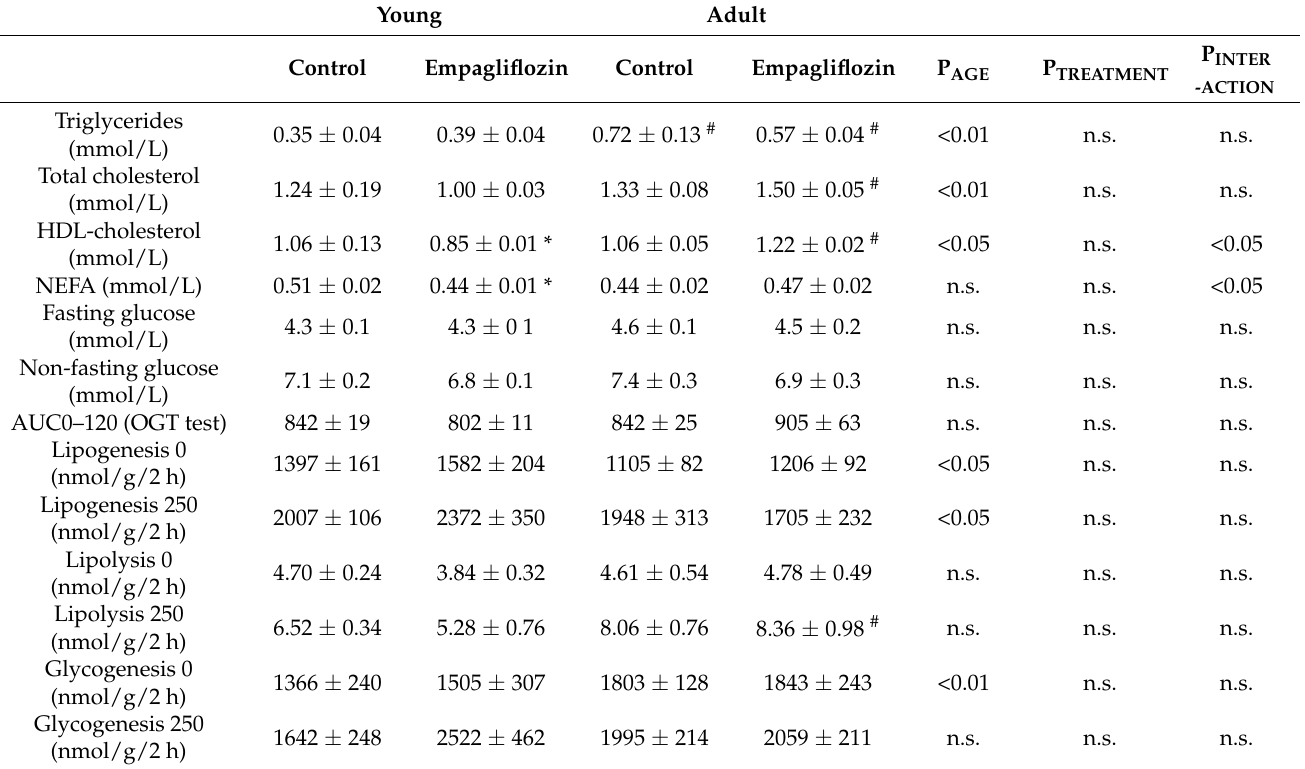
Table 3. Biochemical parameters in the experimental groups at the end of the study. Young Adult Control Empagliflozin Control